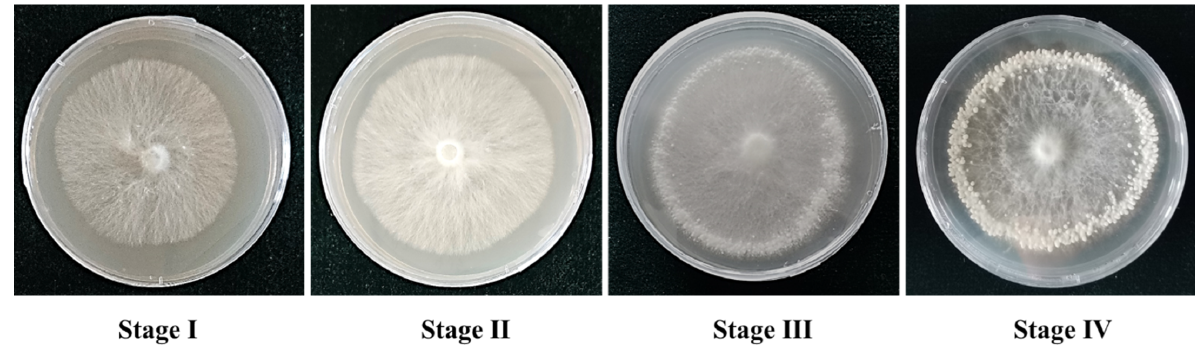
Figure 1. Four stages of primordium formation of P. tuoliensis .